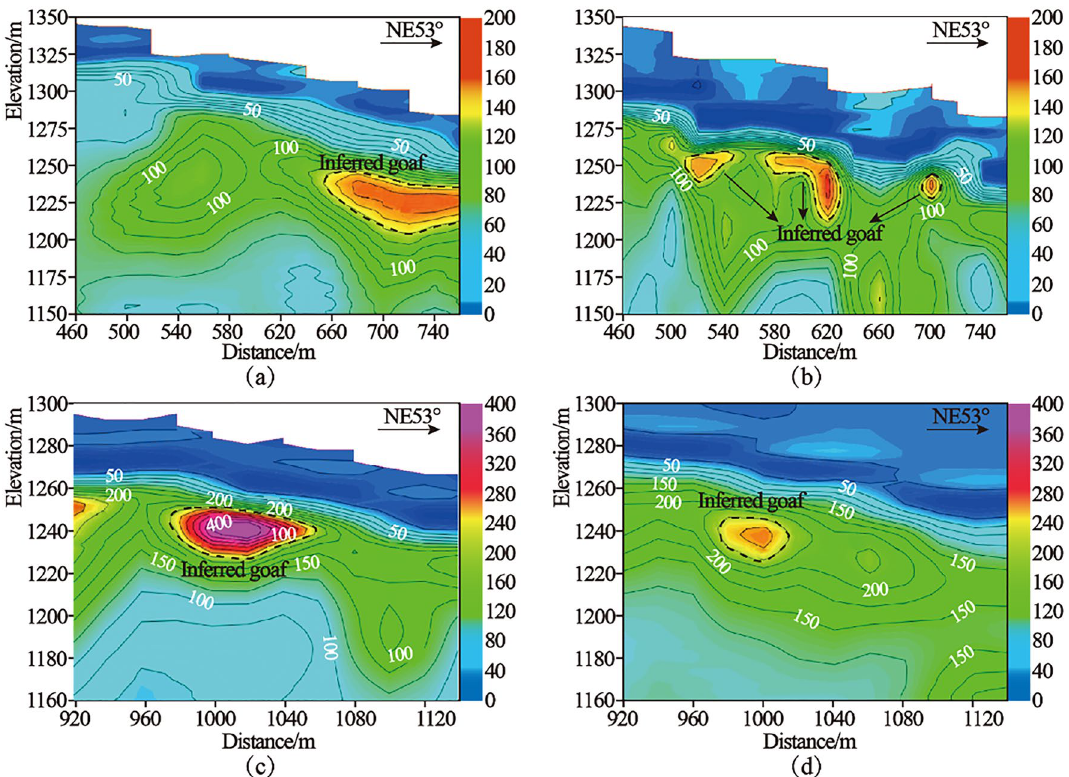
Figure 8. Composite sections of typical apparent resistivity: ( a ) Integrated section of apparent resistivity of S23 line; ( b ) Integrated section of apparent resistivity of S25 line; ( c ) Integrated section of apparent resistivity of S51 line; ( d ) Integrated section of apparent resistivity of S54 line.